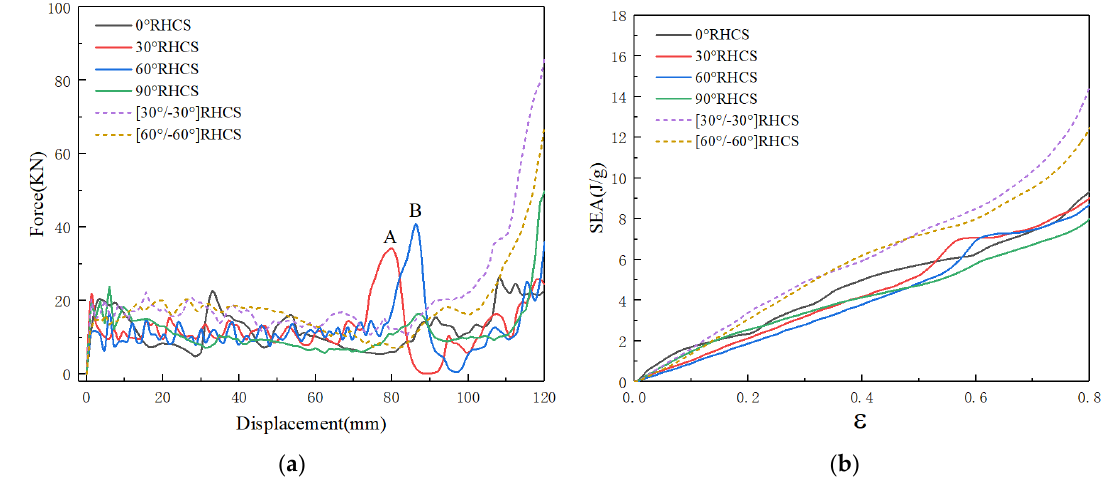
Figure 17. ( a ) The force–displacement curves of RHCSs and ( b ) the SEA curves of RHCSs when V = 60 m/s.